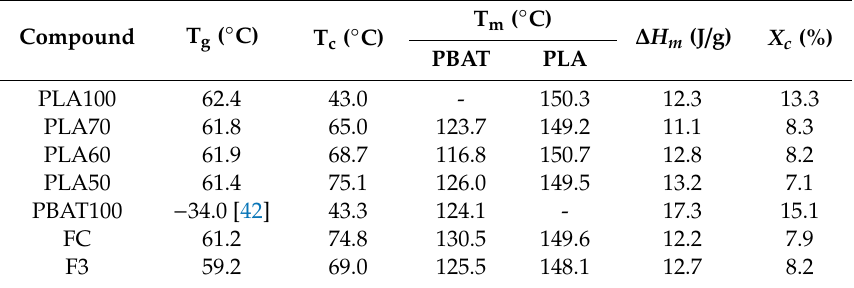
Table 5. Glass transition temperature, melting point, and crystallization temperature for the homopolymers, their blends, and the